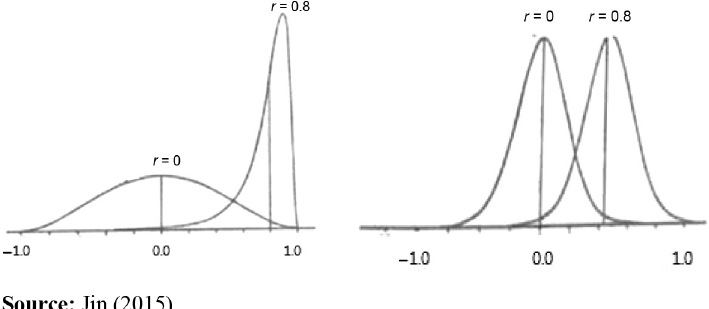
Figure 1. Sample distributions of effect size using Pearson’s r and Fisher’s